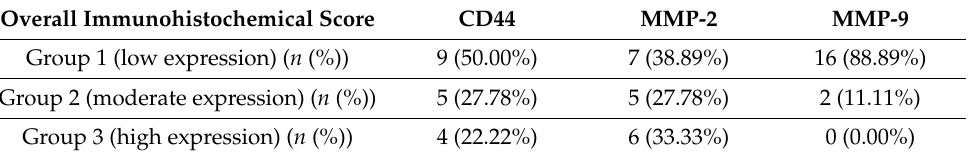
Table 4. CD44, MMP-2, and MMP-9 immunoreactivity of chromophobe renal cell